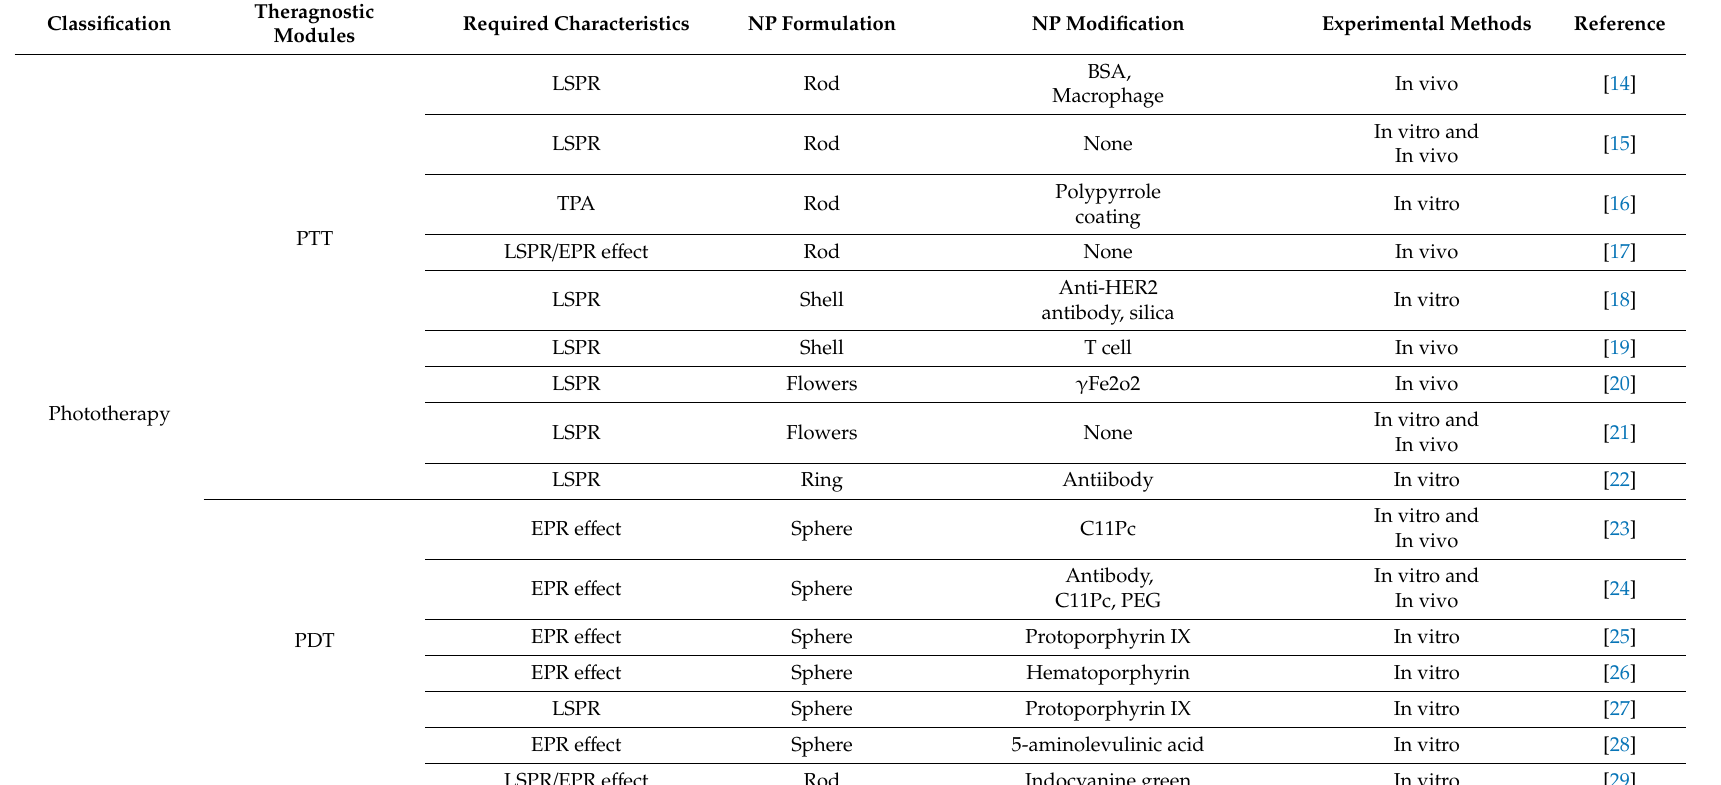
Table 1. Classification of recent research on the use of gold nanoparticles (AuNPs) in cancer theragnosis and their characteristics, formulation, modification, and experimental